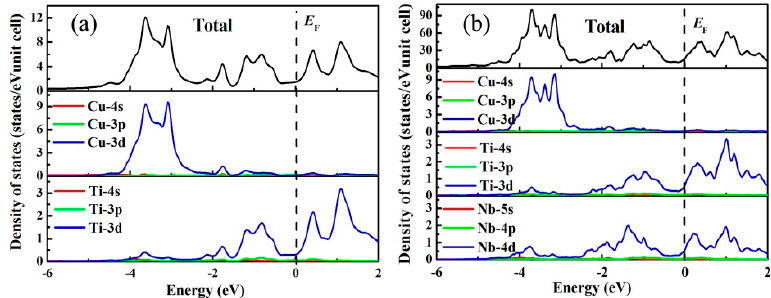
Figure 2. Total and partial density of the state curves of alloys ( a ) Ti 2 Cu and ( b ) Ti 15 Cu 8 Nb.